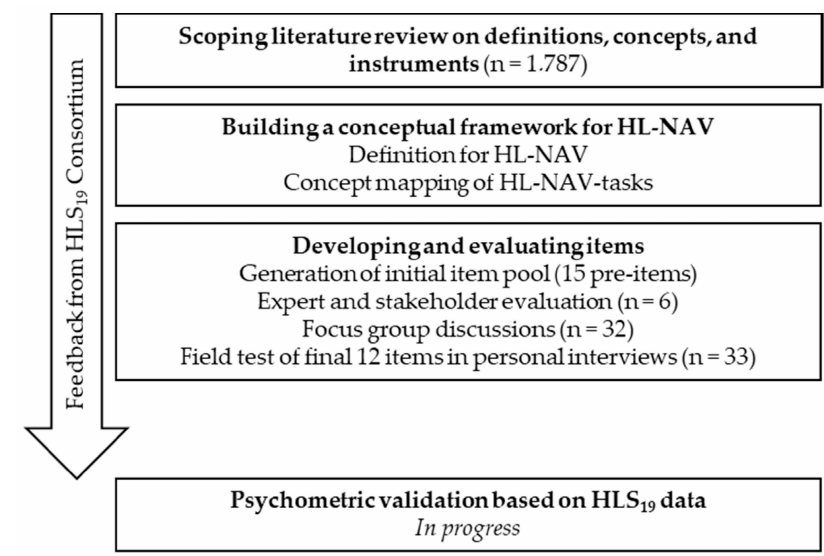
Figure 1. Development process of the instrument to measure